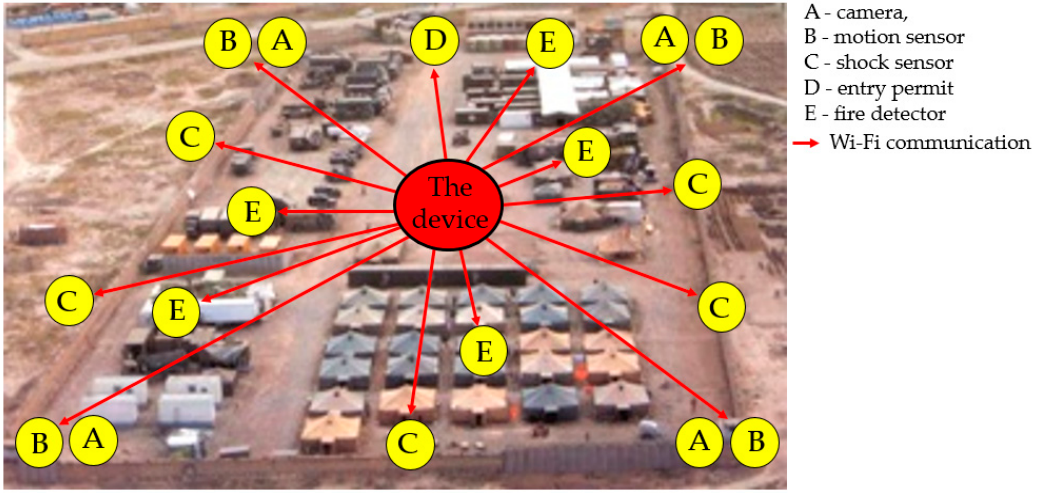
Figure 1. Field Command and Control Centre.